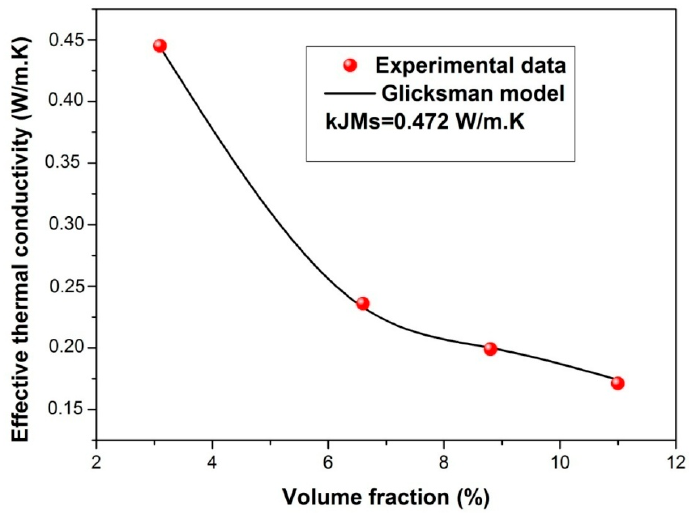
Figure 8. Comparison of JM/mortar composites effective thermal conductivity experimental results with Glicksman model calculated using the estimated k JMs = 0.472